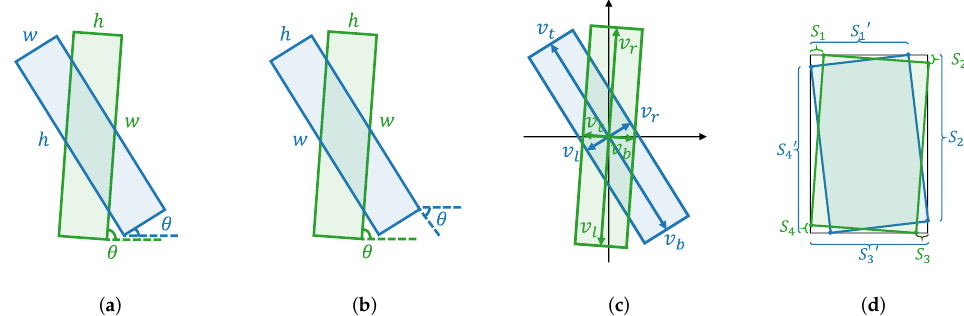
Figure 2. Illustrations of the boundary problem in typical OBB definitions: ( a ) the OpenCV-based box definition [22,46], ( b ) the long-edge-based box definition [19,27], ( c ) the BBAV-like definition [21], and ( d ) the Gliding-Vertex-like definition [45]. In each case, the green box indicates the predicted OBB, while the blue box indicates the corresponding ground